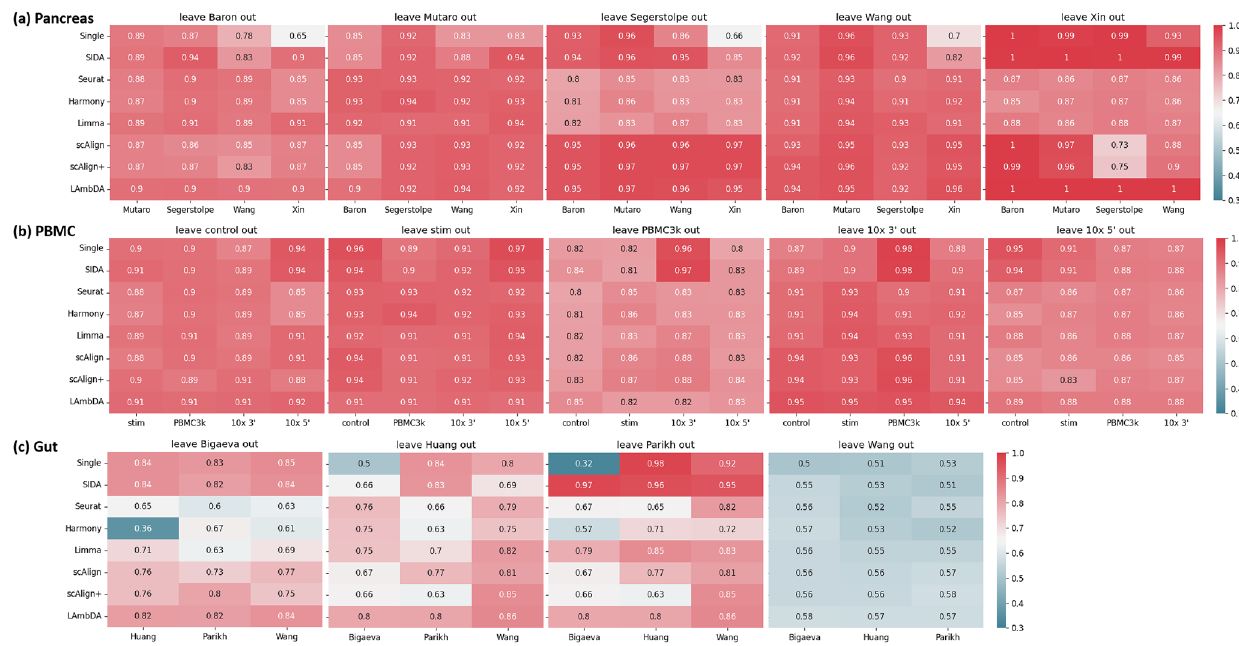
Fig. 6 Evaluating supervised and unsupervised integration algorithms using cell type mapping and leave-one-out strategy. Each heatmap shows the cell type mapping accuracies computed by leaving one batch out of a data collection to serve as the query data. Inside one heatmap, each element corresponds to a particular choice of reference data. Elements in the fi rst row of a heatmap represent cell type mapping accuracies when individual batches were separately used as reference data. In the second row, the reference data were generated by SIDA results converted to different choices of target space. In the remaining rows, the reference data were generated by the existing unsupervised and supervised integration algorithms, with results converted to different choices of target space. a Cell type mapping accuracies in the pancreas data collection. Each heatmap corresponds to one left-out batch. b Cell type mapping accuracies in the PBMC data collection. c Cell type mapping accuracies in the gut data